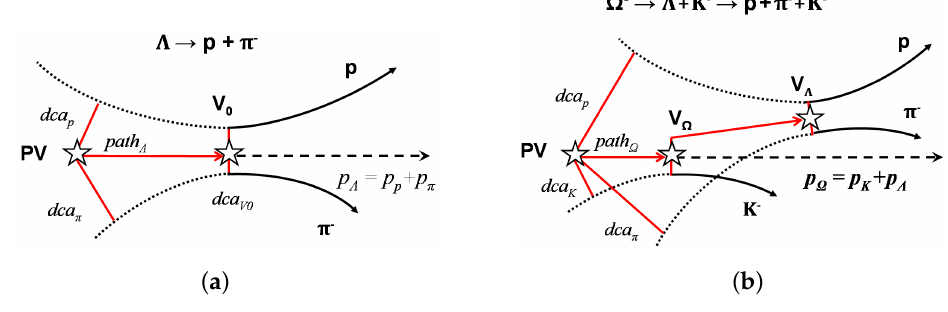
Figure 2. ( a ) Event topology of two-particle decays of a neutral particle (e.g., Λ → p + π − ); ( b ) event topology of cascade-type decays (e.g., Ω − → Λ + K − → p + π − + K − ) (transverse view). Here, dca p , dca π , and dca K are the distances of the closest approach of the decay tracks to the primary vertex PV , dca V 0 is the distance between daughter tracks in the decay vertex V 0 , path is the decay length, p p π , p K , p Λ , and p Ω are momenta of